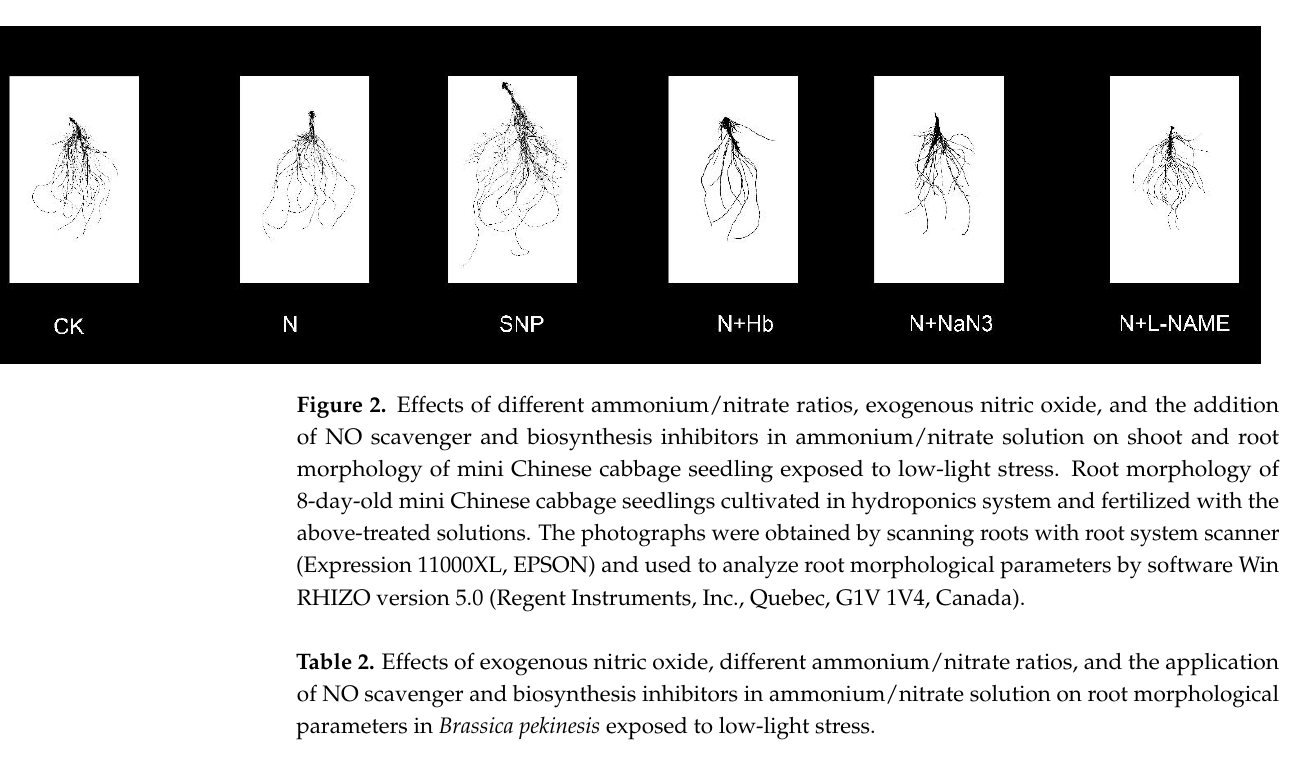
Table 2. Effects of exogenous nitric oxide, different ammonium/nitrate ratios, and the application of NO scavenger and biosynthesis inhibitors in ammonium/nitrate solution on root morphological parameters in Brassica pekinesis exposed to low-light stress.